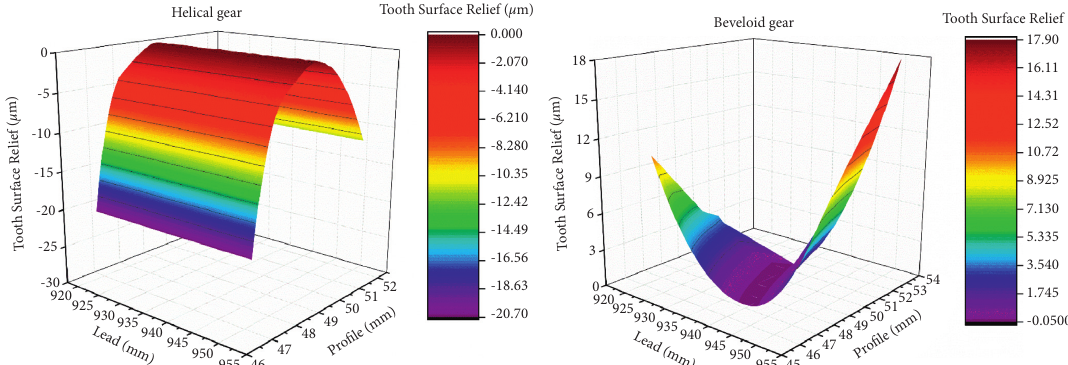
Figure 6: Topographies of tooth surface modification.